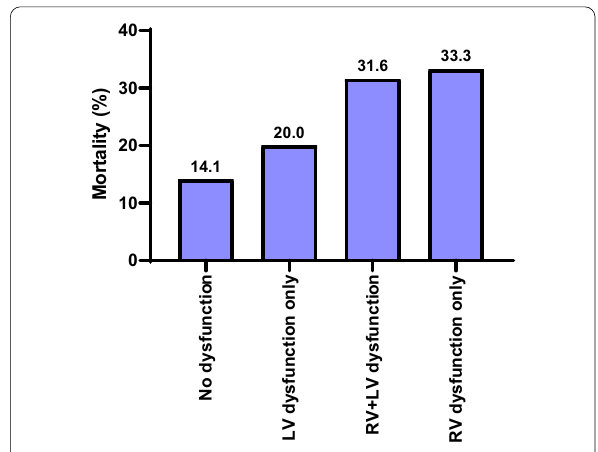
Fig. 2 Mortality according to ventricular dysfunction subtypes